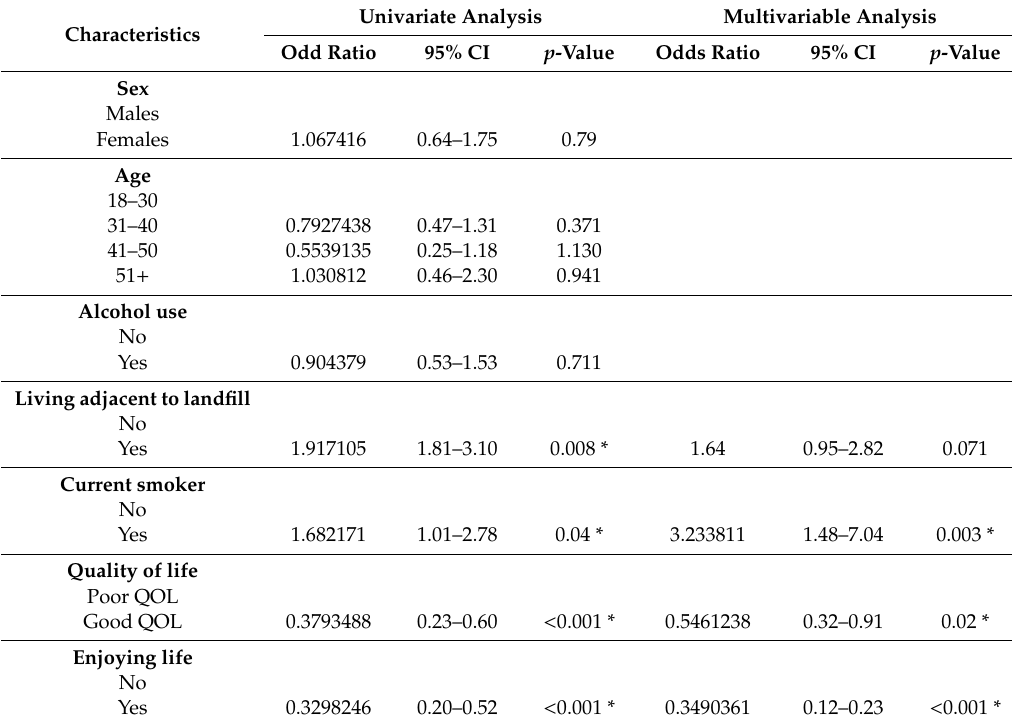
Table 3. Univariate and Multivariable analysis of the predictors of common mental disorders among informal waste